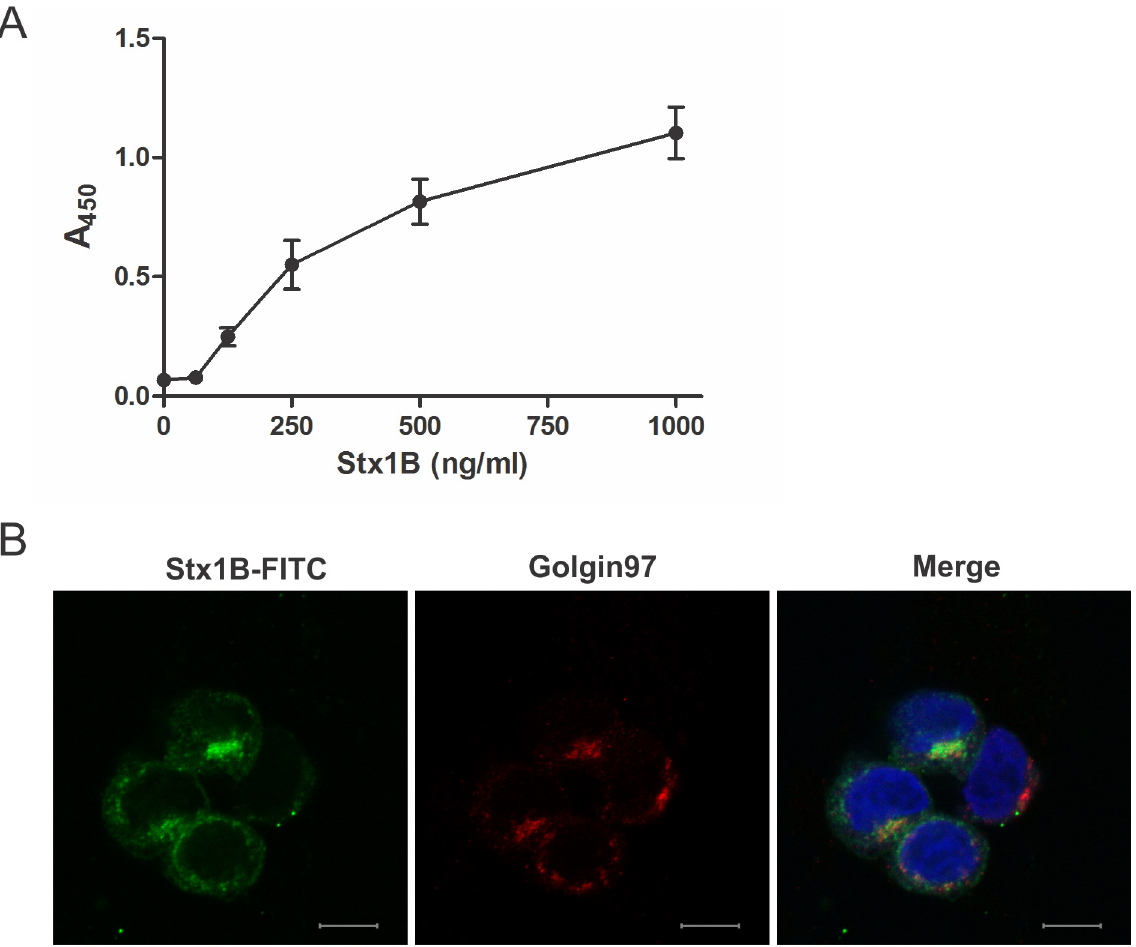
Fig 1. Ability of recombinant Stx1B to bind to Gb 3 receptor in vitro . (A) Binding of serially diluted Stx1B to Gb 3 as determined by ELISA using THE ™ His tag antibody. A 450 : Absorbance at 450 nm. Error bars denote standard deviations. (B) Internalization of FITC-labelled Stx1B into HeLa cells. Golgi apparatus was detected with mouse anti-human Golgin-97 primary antibody and Alexa Fluor 555-conjugated donkey anti-mouse secondary antibody (red). DAPI staining was used to label nuclei (blue). Bars = 10 μ